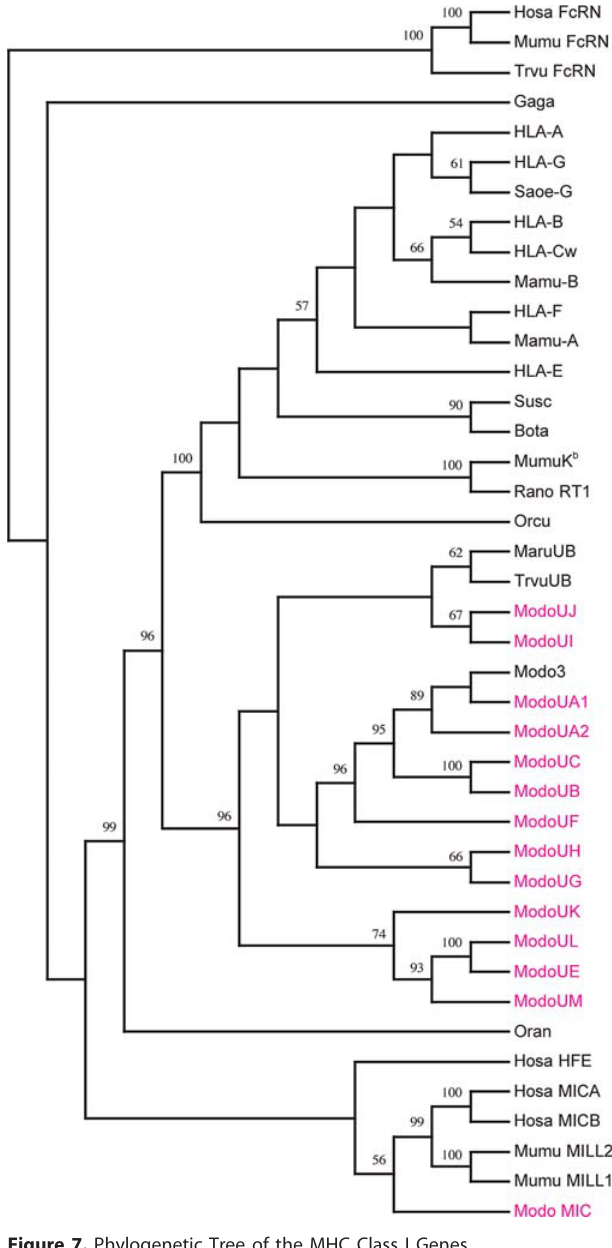
Figure 7. Phylogenetic Tree of the MHC Class I Genes MHC class I phylogeny based on nucleotide alignments corresponding to exons 2, 3, and 4 of MHC Class Ia and Ib loci from M. domestica and representative vertebrate species. DOI: 10.1371/journal.pbio.0040046.g007